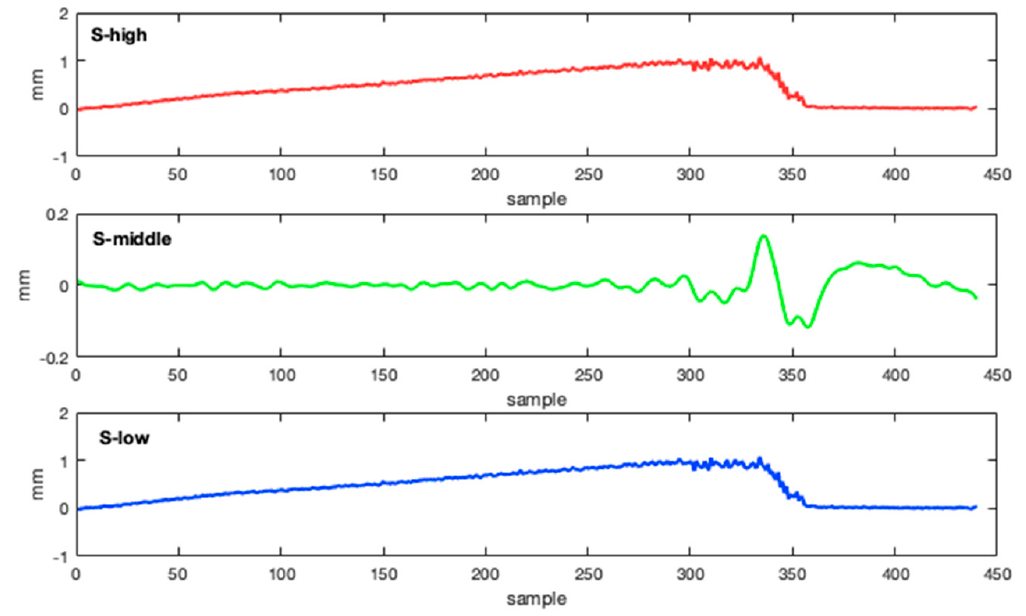
Figure 7. Signal reconstruction of EEMD of “Yangdong Line.”